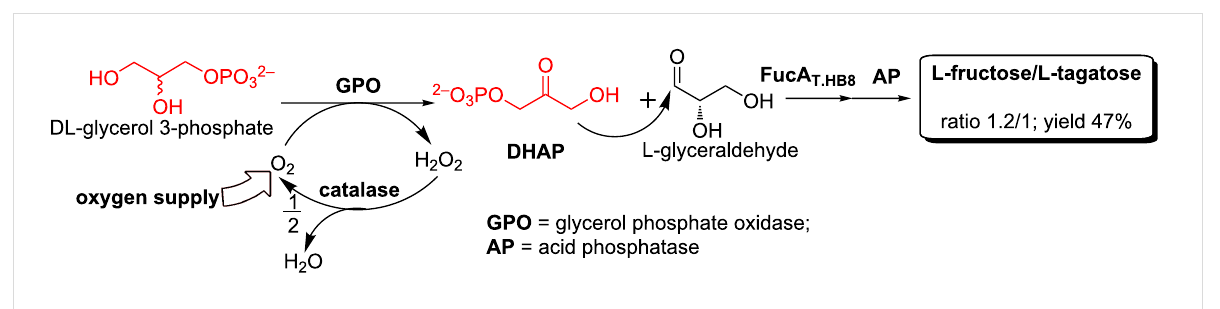
Scheme 6: Biosynthesis of L-tagatose.